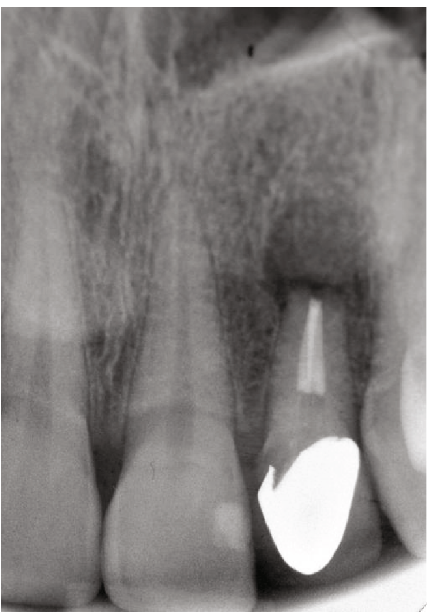
Figure 1: Preoperative X-ray.